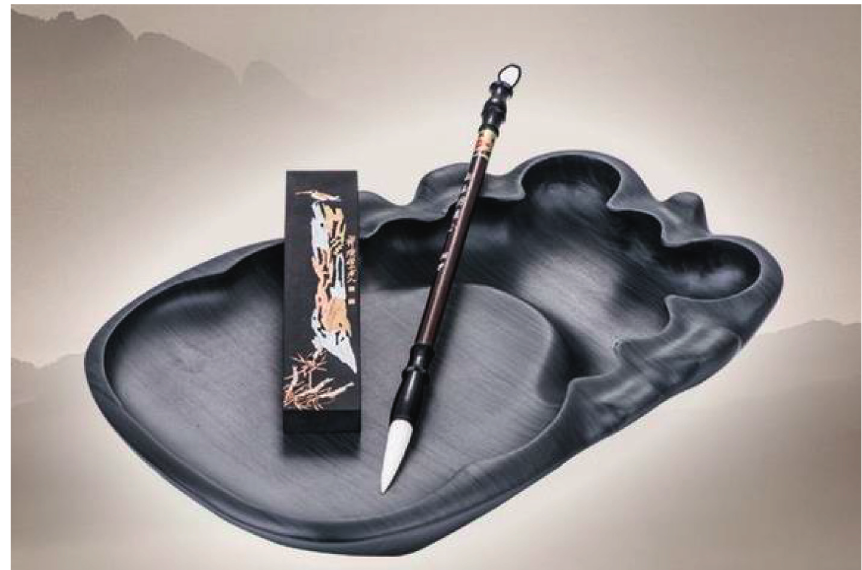
Figure 1: Calligraphy practice products